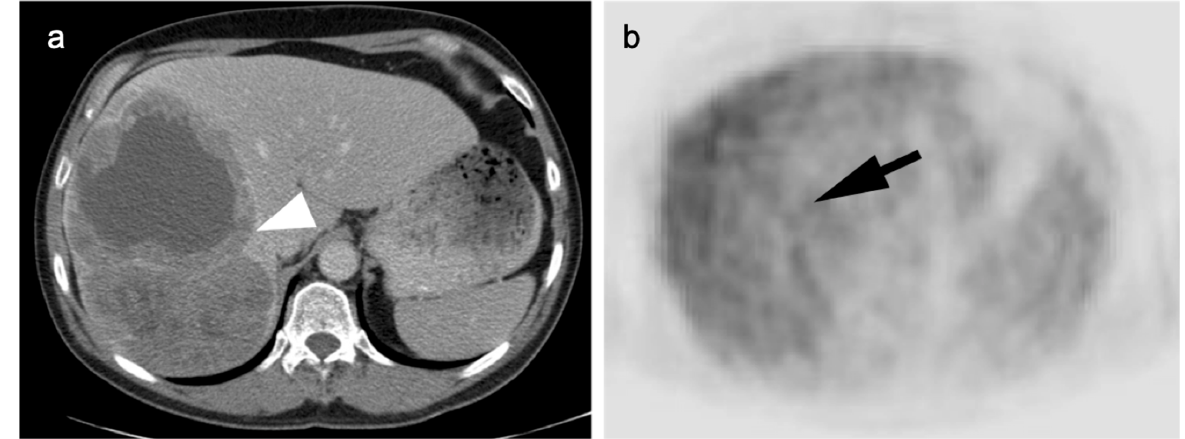
Figure 14. Well-differentiated HCC shown on contrast-enhanced CT ( a ) and axial FDG PET ( b ). The large lesion on CT (white arrowhead) is isometabolic to the remainder of the liver on FDG PET-CT (black arrow), which is a typical feature of well-differentiated HCC.